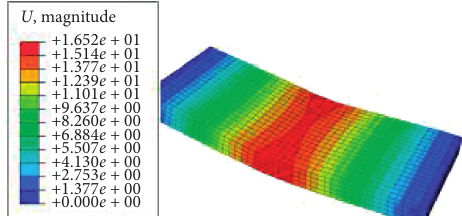
Figure 27: Deformation cloud chart of the concrete under ultimate load.